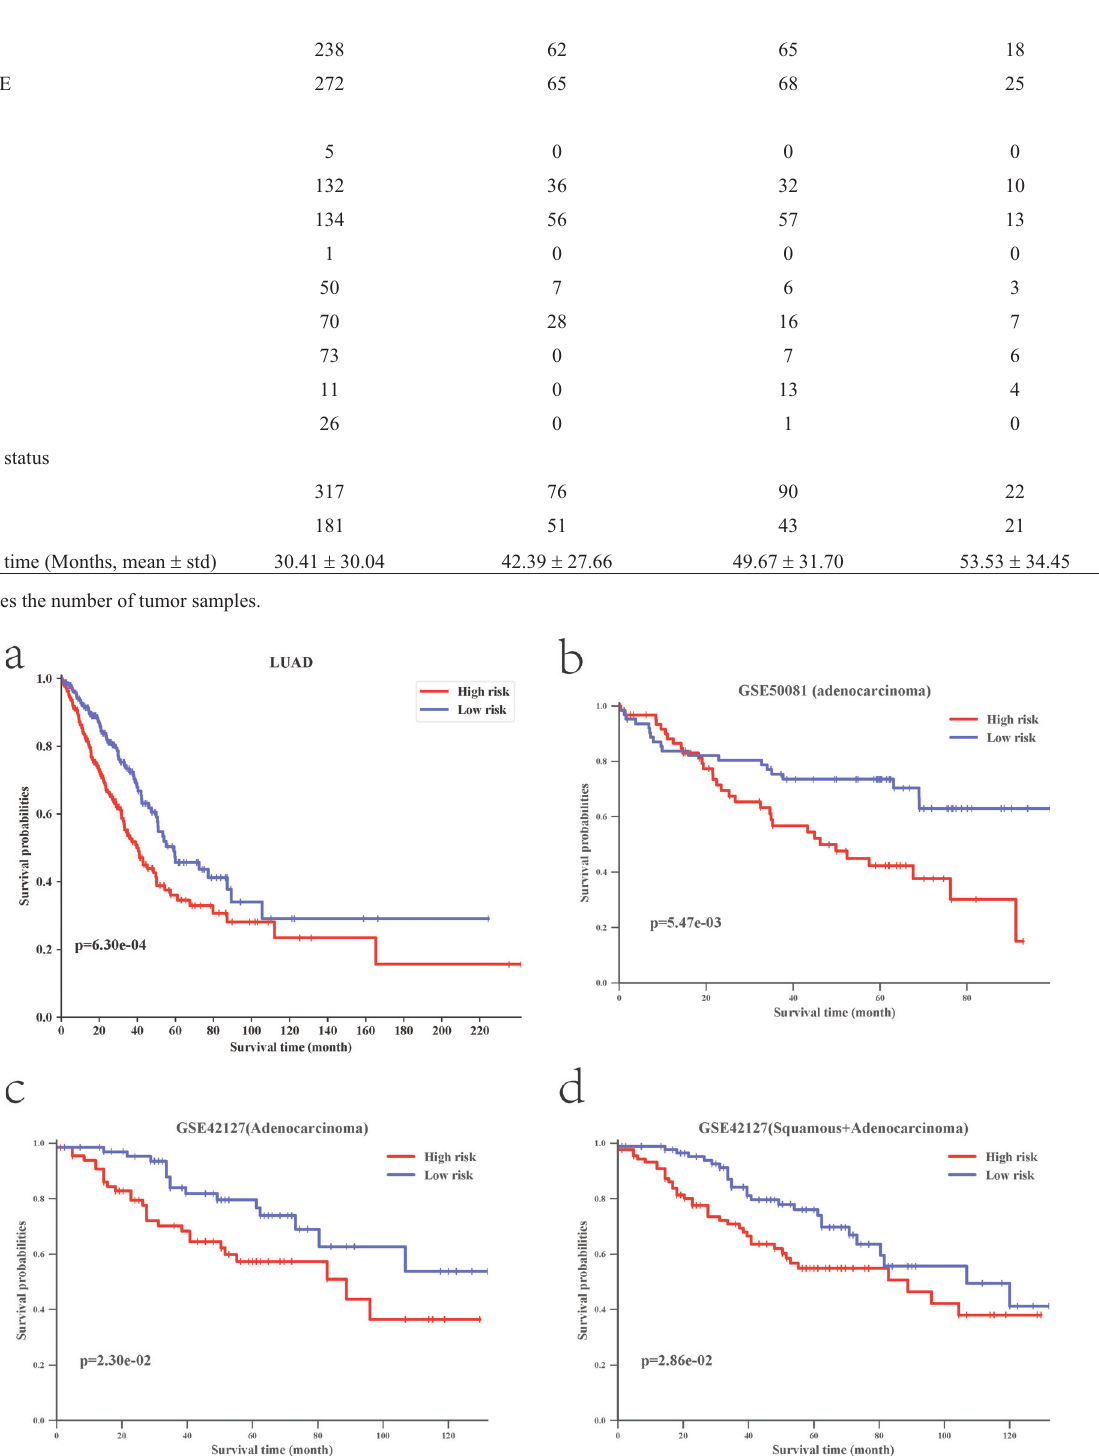
Figure 3 - Screening of the prognostic markers for lung adenocarcinoma and the construction of the prognostic classifier. (a) K-M curve in the TCGA training dataset. (b,c,d) K-M curve in the independent validation